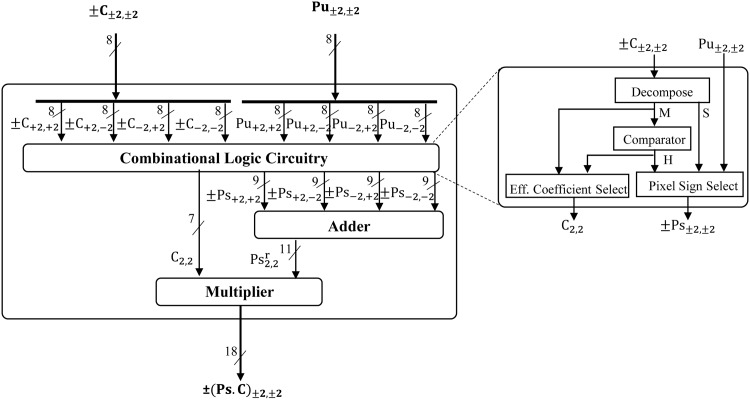
Internal architecture of processing element (PE2,2).